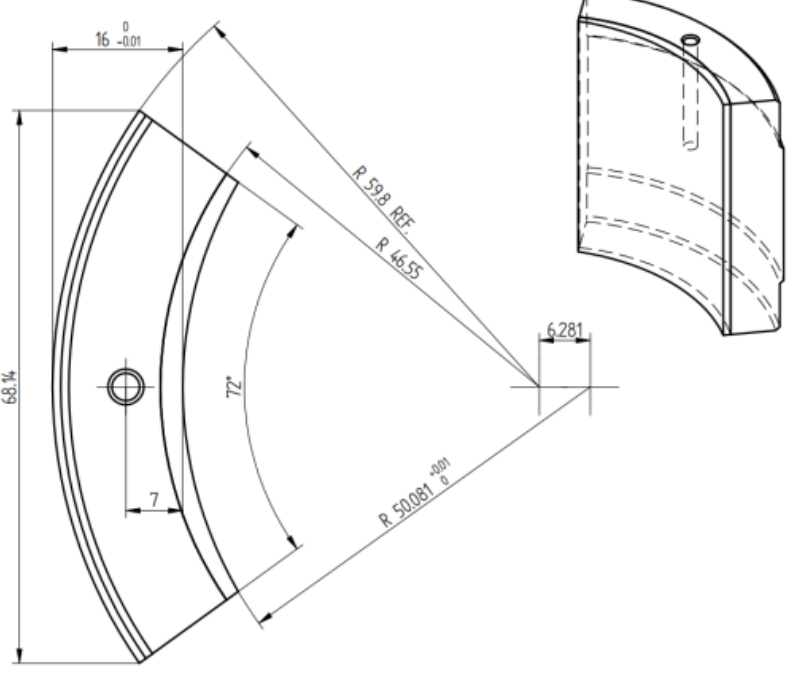
Figure 10. Sketch and dimension of one pad in a TPJB.